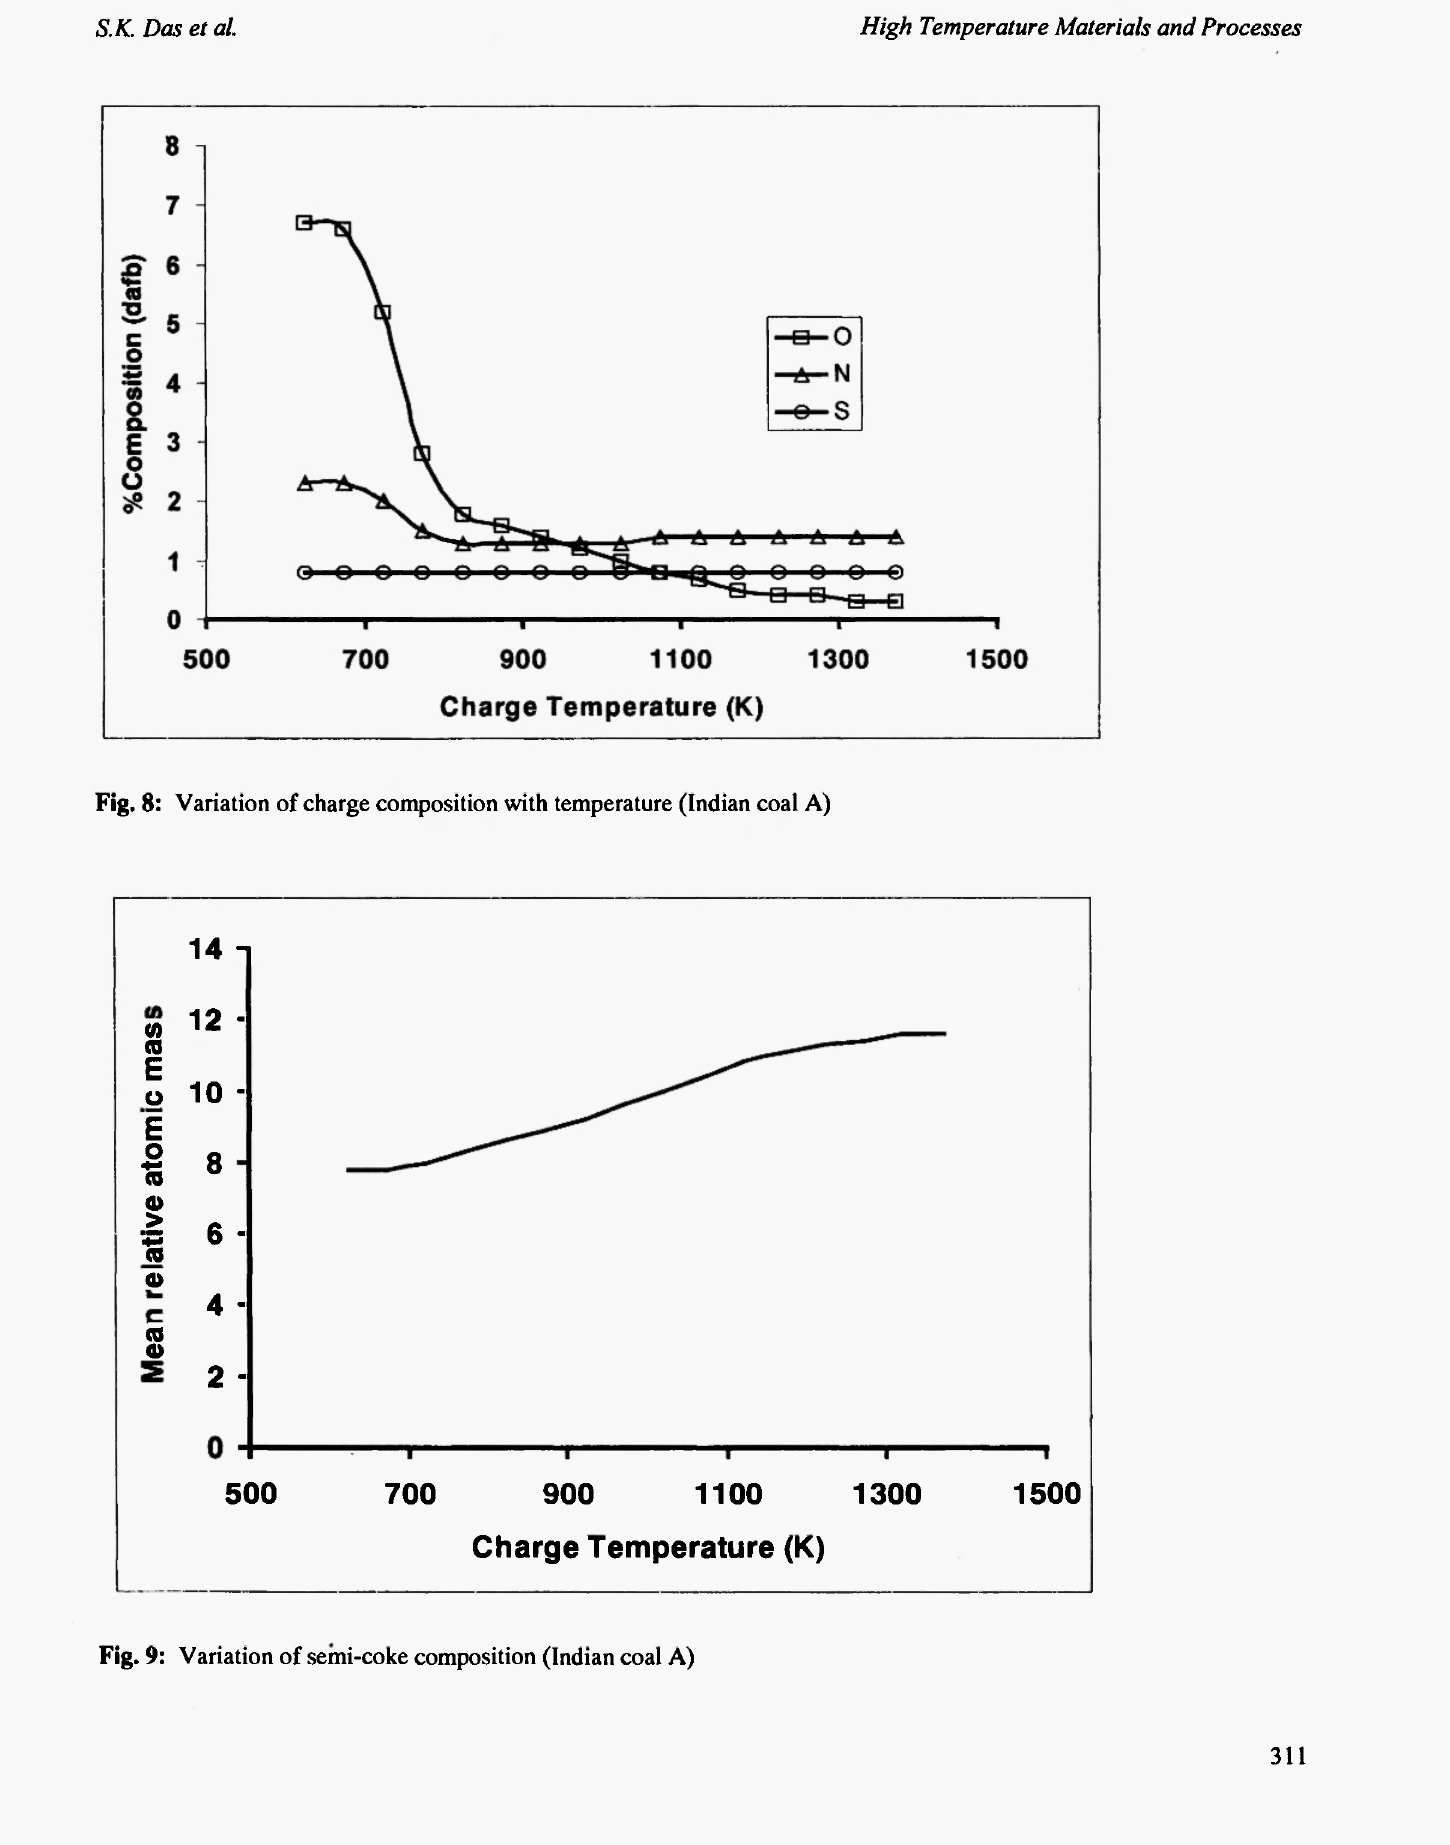
Fig. 9: Variation of semi-coke composition (Indian coal